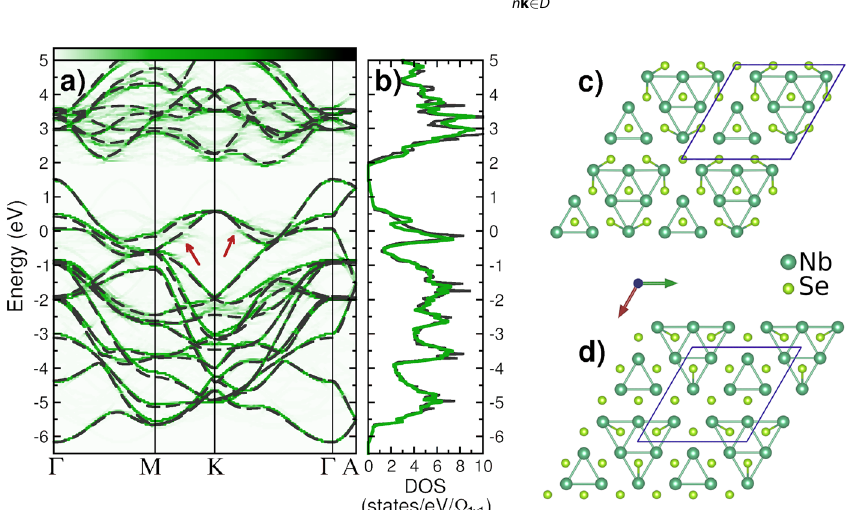
Fig. 2 Electronic properties and CDW structure. a Unfolded band structure and ( b ) electronic DOS of the CDW (green) and undistorted phase (black). CDW reconstruction of layers ( c ) L 2 , chalcogen-centered pattern, and ( d ) L 1 , hollow-centered pattern, in the Ω 3×3 unit cell (blue frame). The modulation of the atomic positions is highlighted by using a 2.53 Å cutoff for the plotted Nb – Se